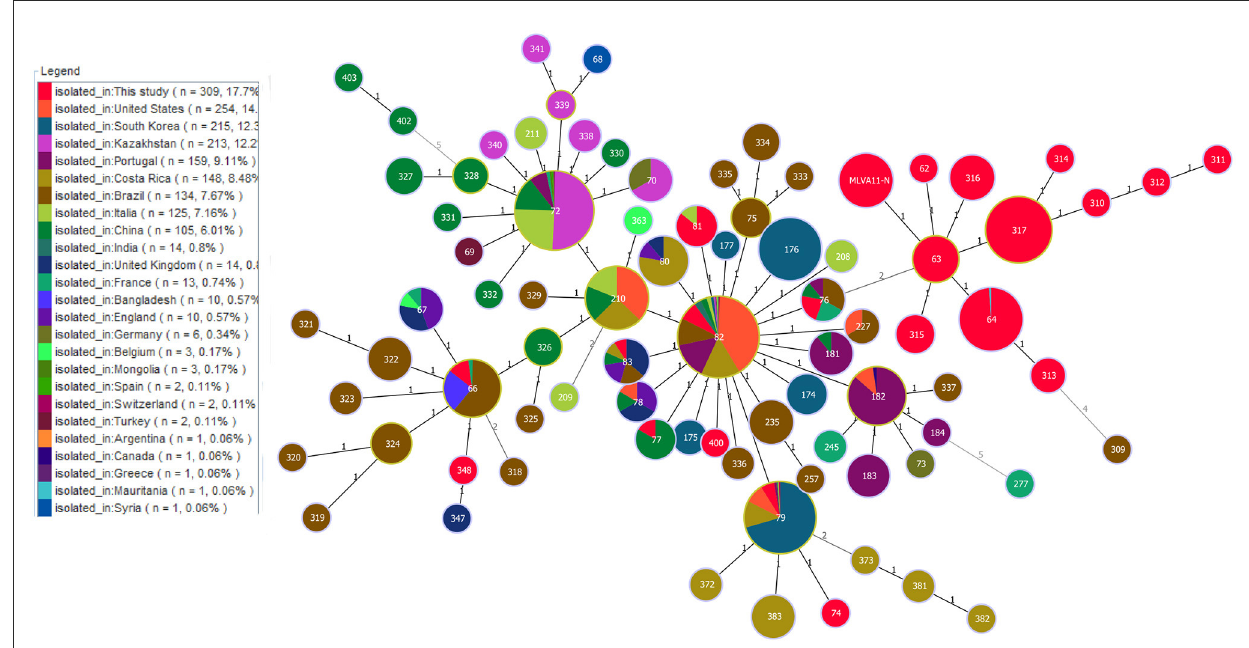
FIGURE4 Geographic origin analysis of B. abortus strains in West Africa on a global scale based on the multi-loci variable number of tandem repeats (VNTR) 11 data worldwide. Color coding according to countries. Circle size indicates the number of strains.